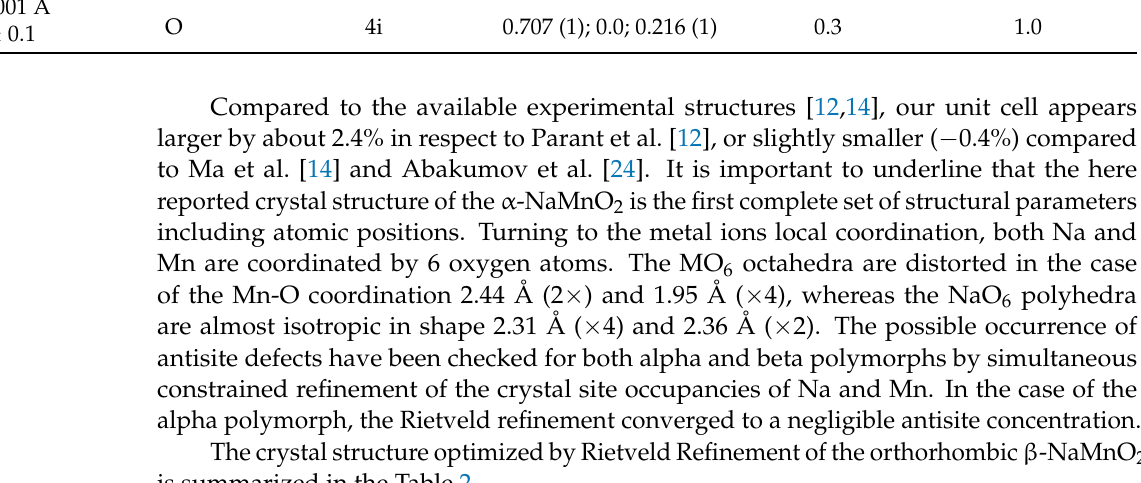
Table 2. Crystal structure parameters refined by Rietveld optimization for the β -NaMnO 2 sample (Space group: Pmmn; R wp = 7.162%, G.o.f. = 1.31). Errors on the last digit of the optimized atomic positions (cell axes fractions) are reported in parentheses. The Debye–Waller/DB factors have an error of ± 0.1. Estimated antisite defects between Mn and Na atomic sites are 9.4%. The amount of α -NaMnO 2 has been checked by multiphase refinement by assuming the presence of